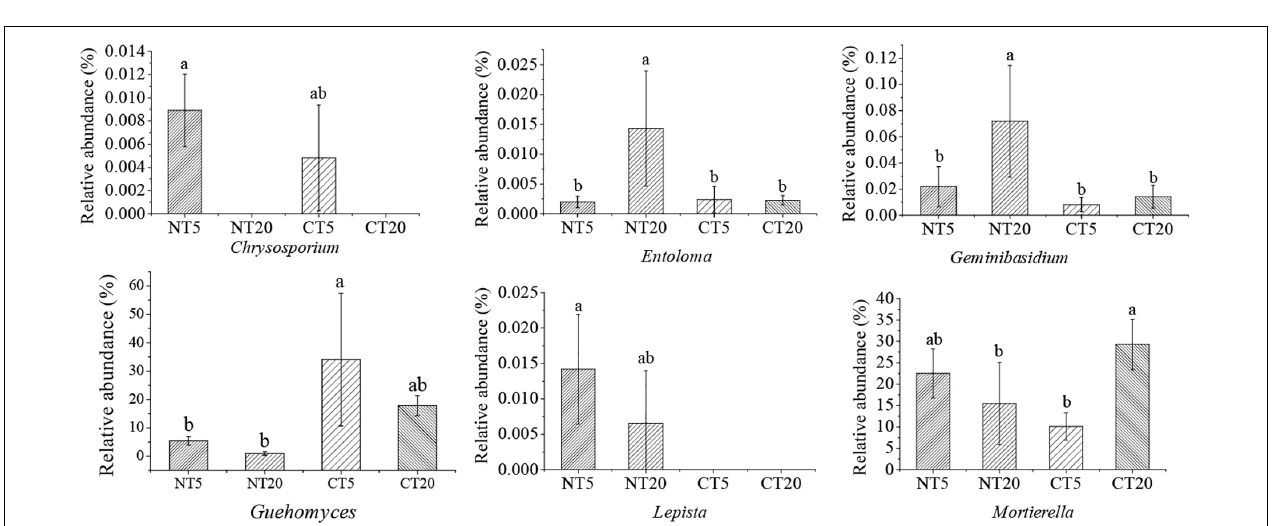
FIGURE 4 | Relative abundance of soil potential beneficial fungi under NT and CT. Different small letters indicated difference between different treatments ( P < 0.05).